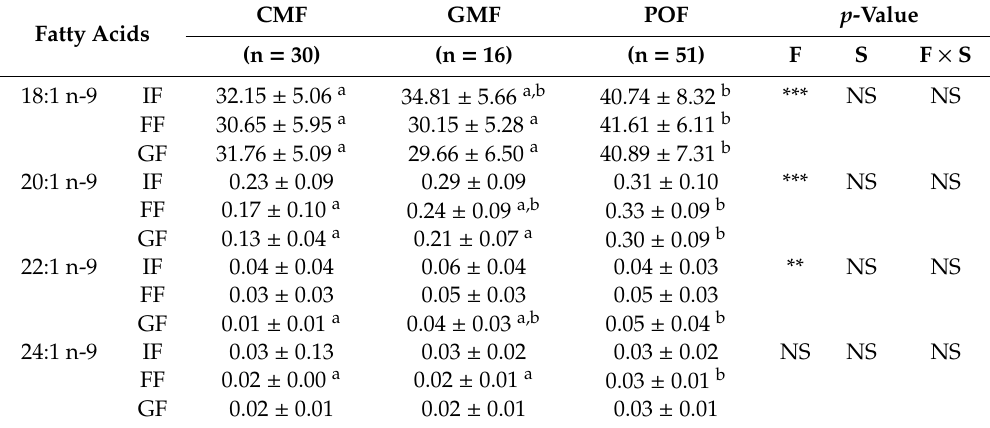
Table 1. n-9 Fatty acid composition (wt%) of infant